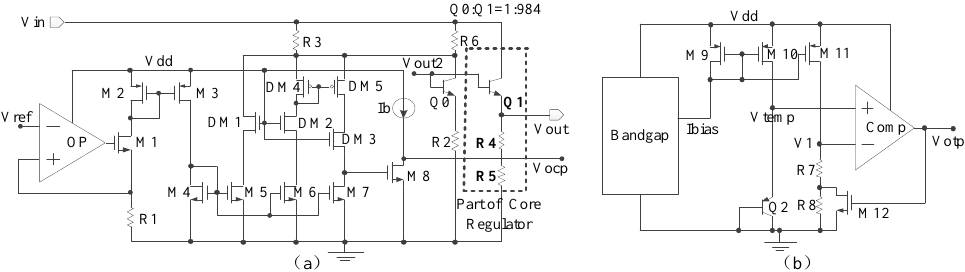
Figure 9. Protection circuits; ( a ) over-current protection (OCP) circuit; ( b ) over-temperature protection (OTP) circuit.